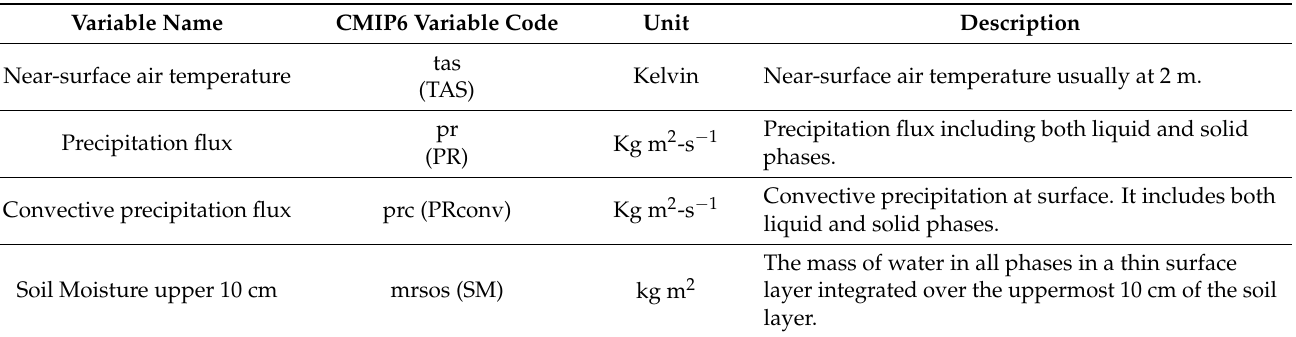
Table A2. List of fluxes and other variables from